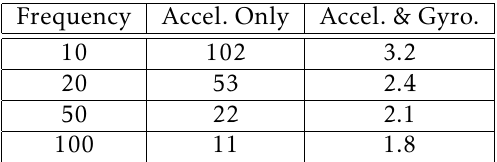
Table 3. SPW-2: Battery Lifetime Approximations in Days Frequency Accel.